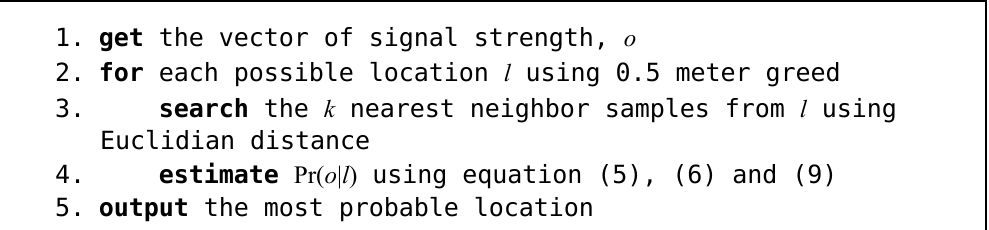
Figure 1. Proposed